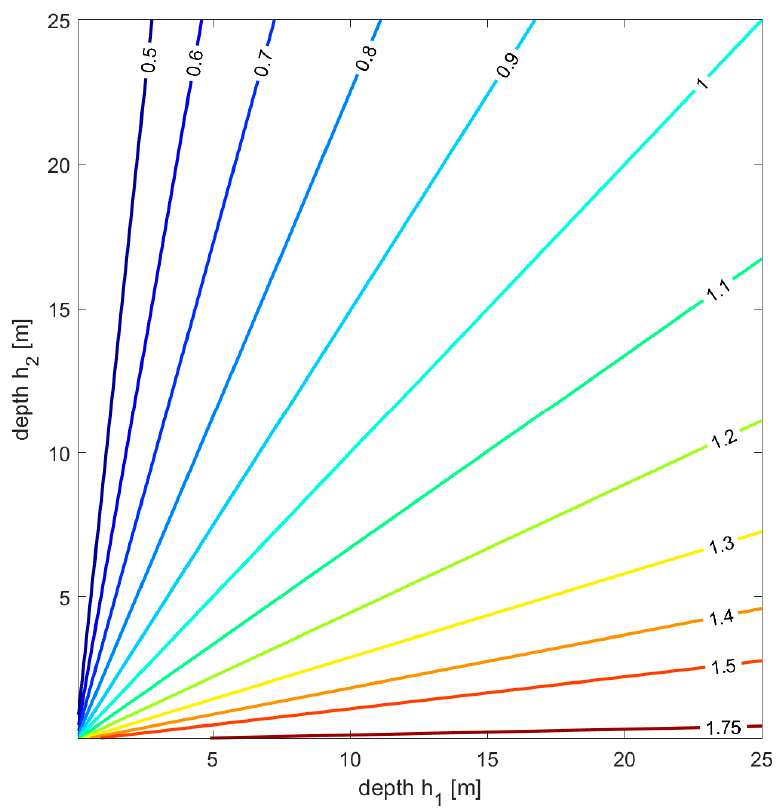
Figure 4. Visualization of the transmission coefficient at abrupt bathymetric changes for different depths and constant widths upstream and downstream of the bathymetric change.